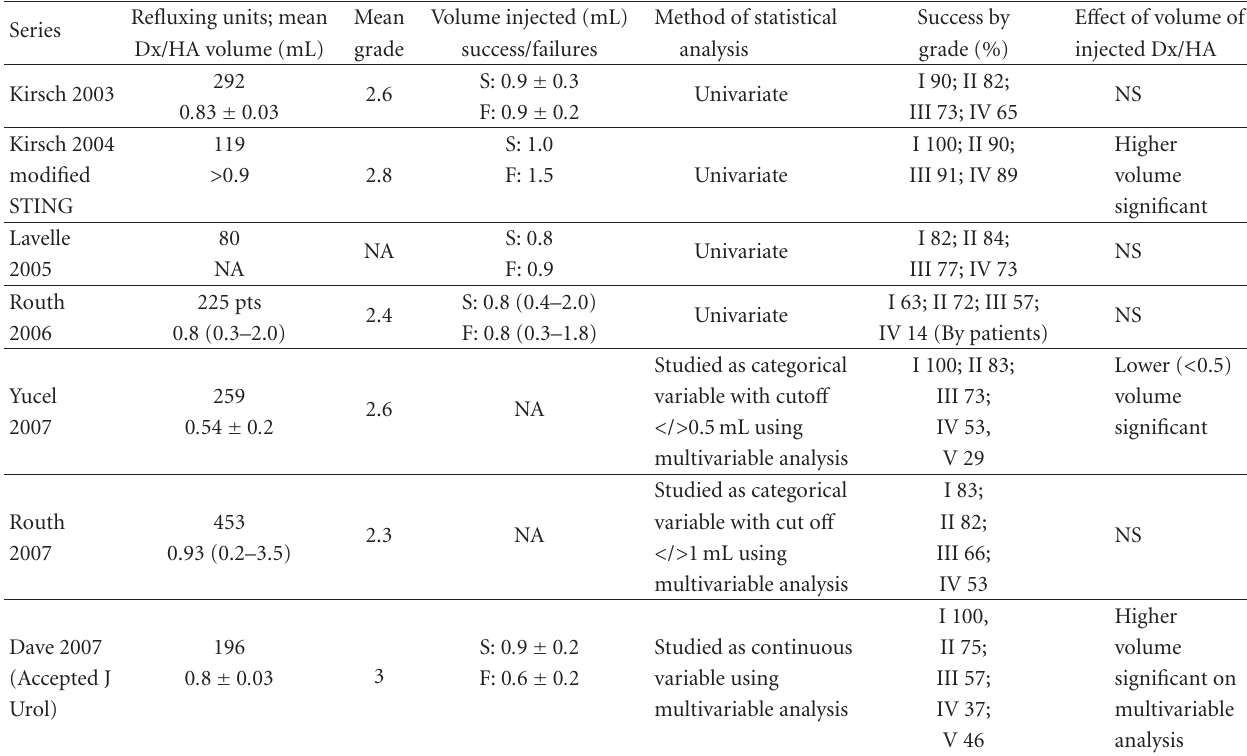
Table 2: Studies investigating the e ff ect of injected Dx/HA volume on VUR